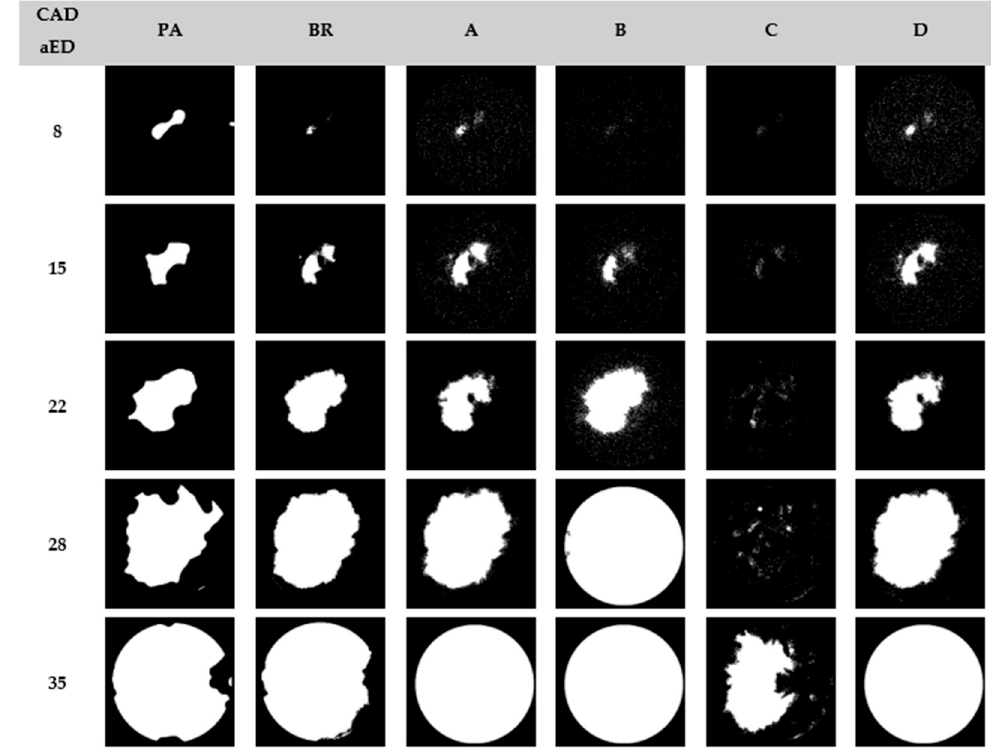
Figure A1. Binarized frames of BDI 1.4 air/fuel ratio for the different cases studied.